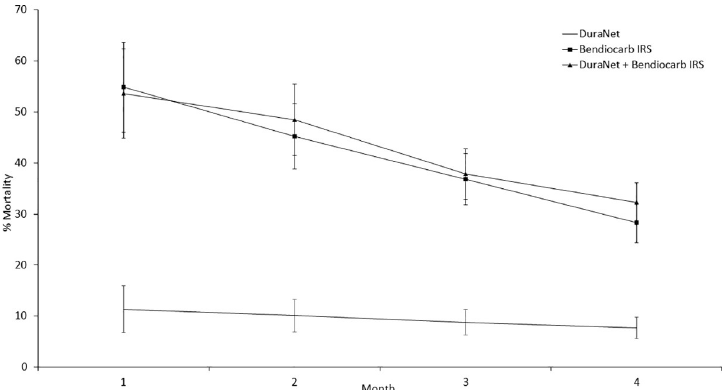
Fig 3. Monthly mortality rates of wild, free-flying pyrethroid-resistant Anopheles gambiae sensu lato entering experimental huts with bendiocarb IRS applied alone and in combination with DuraNet 1 in Cov è , southern Benin. Mortality was cumulated over successive months. Error bars represent 95%